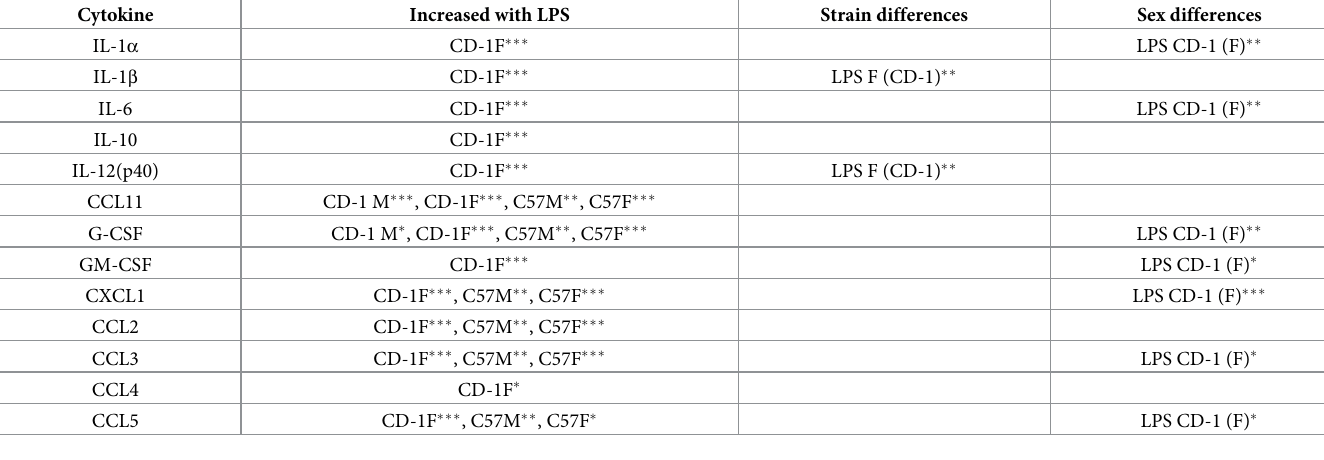
Table 5. Significant changes in brain cytokines according to sex and strain following LPS treatment.